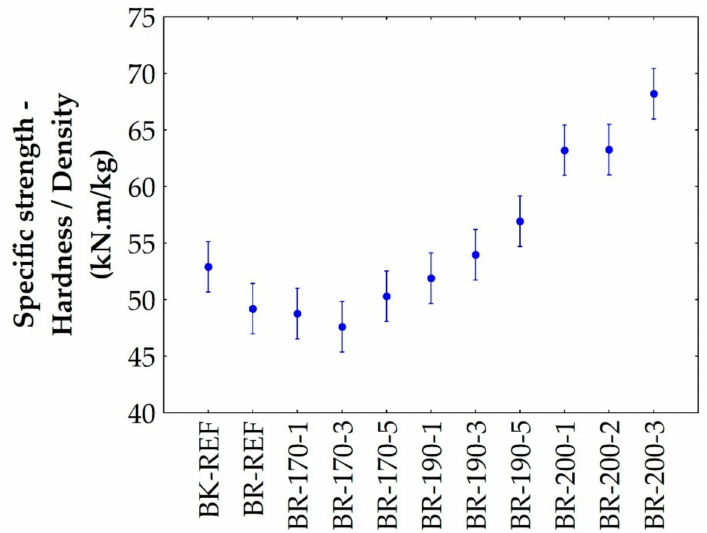
Figure 12. The graphic visualization of the e ff ect of heat-treatment temperature and heat-treatment time limit (peak stage) on specific strength. BK-REF = untreated beech; BR-REF = untreated birch; BR-170-1 = birch treated at 170 ◦ C / 1 h; BR-170-3 = birch treated at 170 ◦ C / 3 h; BR-170-5 = birch treated at 170 ◦ C / 5 h; BR-190-1 = birch treated at 190 ◦ C / 1 h; BR-190-3 = birch treated at 190 ◦ C / 3 h; BR-190-5 = birch treated at 190 ◦ C / 5 h; BR-200-1 = birch treated at 200 ◦ C / 1 h; BR-200-2 = birch treated at 200 ◦ C / 2 h; BR-200-3 = birch treated at 200 ◦ C / 3 h.